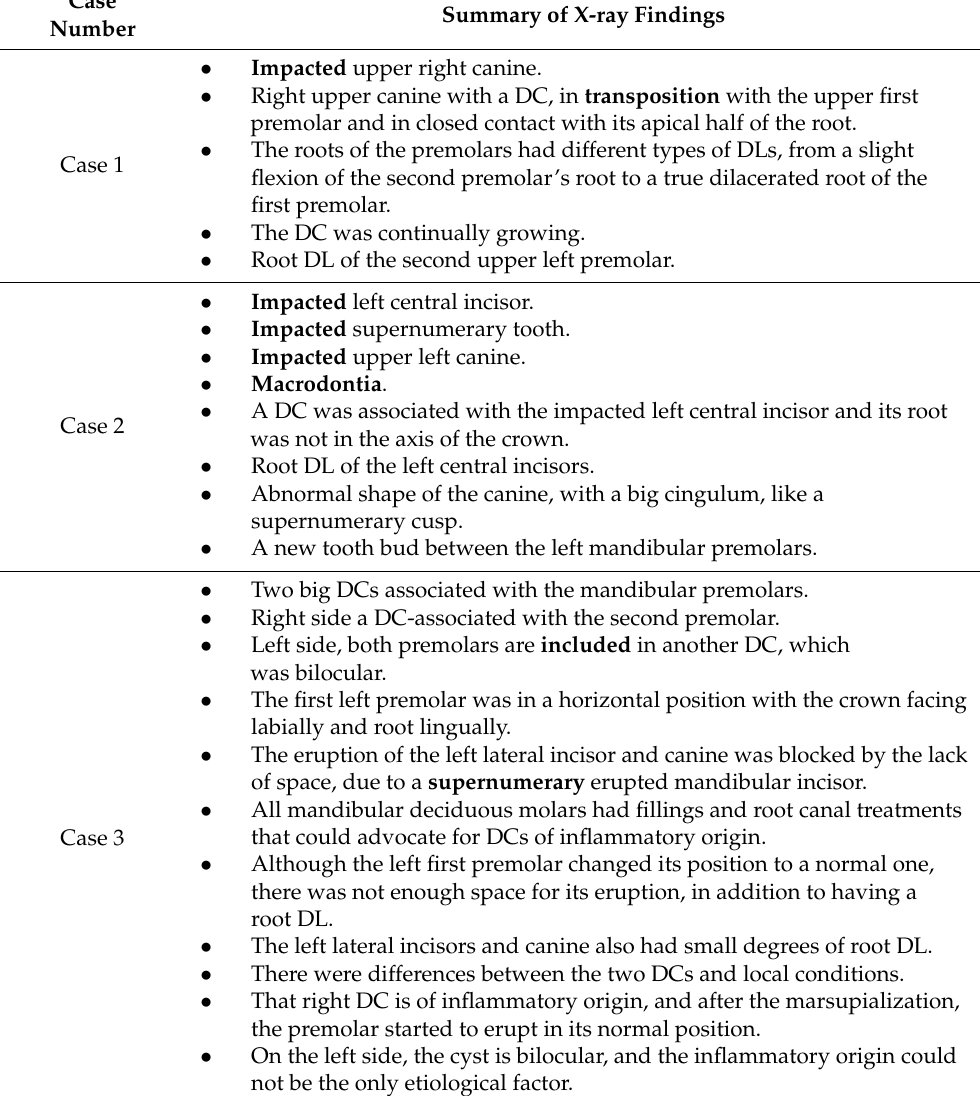
Table 1. Summary of the radiological findings of the cases described above—the association between DL and other dental anomalies of genetic